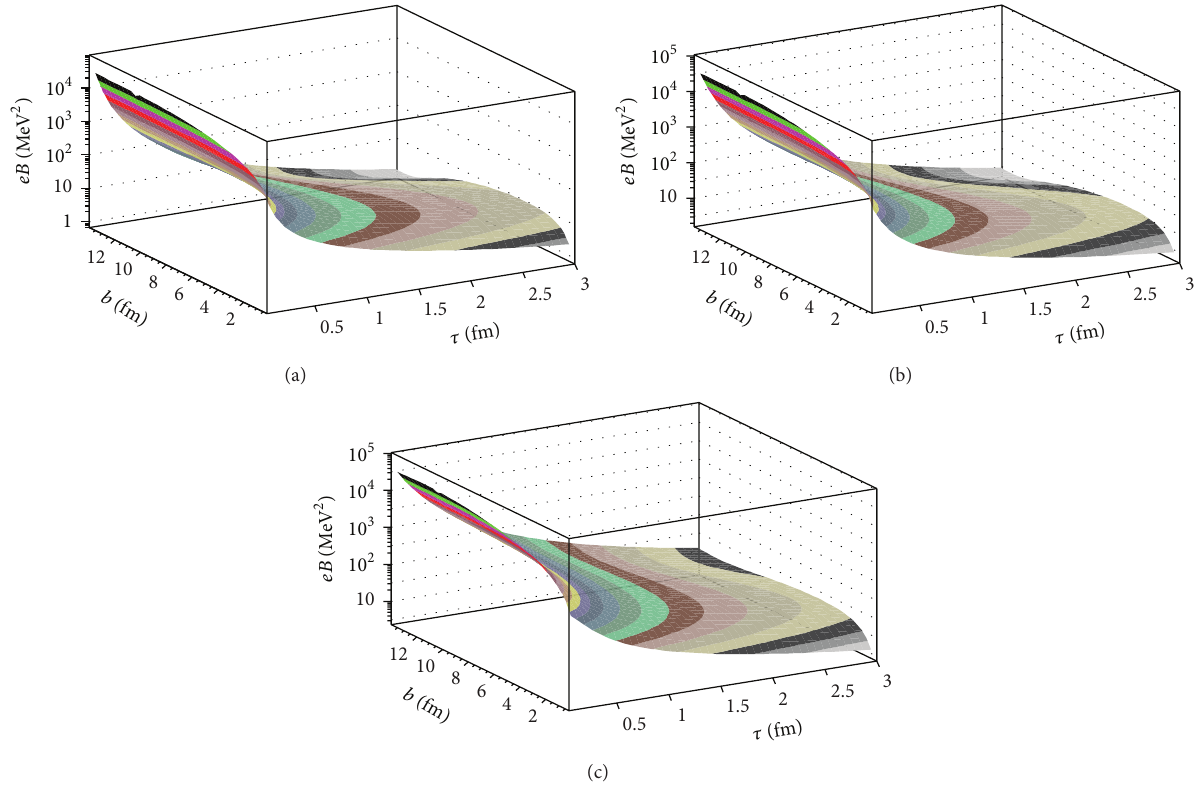
Figure 2: The dependencies of the magnetic field on proper time and impact parameters for Au-Au collisions at RHIC collision energies with √𝑠 = 200 GeV (a), √𝑠 = 130 GeV (b), and √𝑠 = 64 GeV (c), respectively.